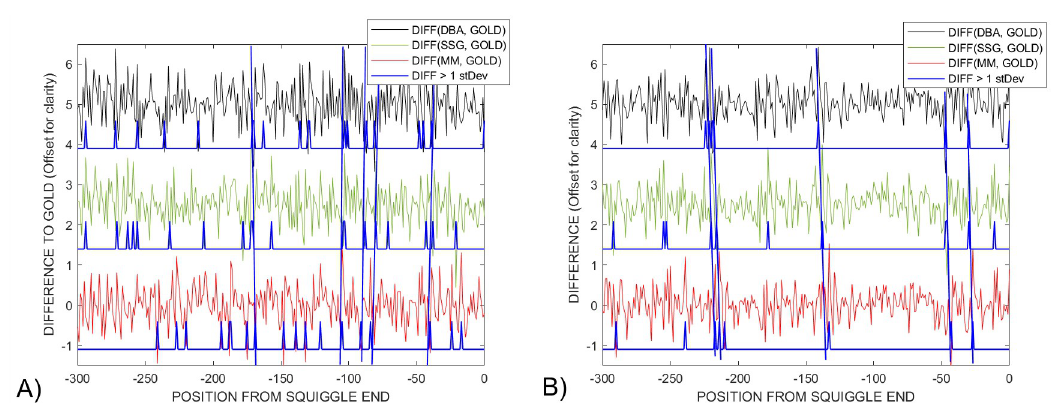
Fig 15. Comparison of the differences between the amplitudes of the warped gold and DBA (black), SSG (green) and MM (red) voted-on DTWA consensus signals for Sequin A) R1-71-1 and B) R2-55-3 studies. The short blue spikes indicate where higher than average differences exist between the study’s gold standard and a consensus signal, many larger differences being common across all consensuses, blue lines. However, closer examination of all differences show that they cannot be represented as experimental produced gaussian deviations around a mean, but are equivalent, small systematic differences common across all DTWA